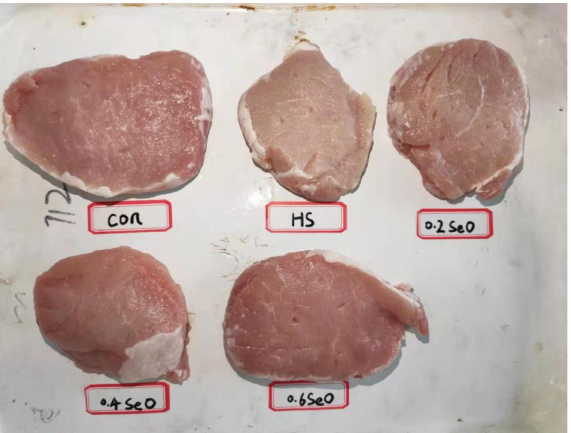
Figure 2. Photographs of representative longissimus dorsi muscle samples 24 h after